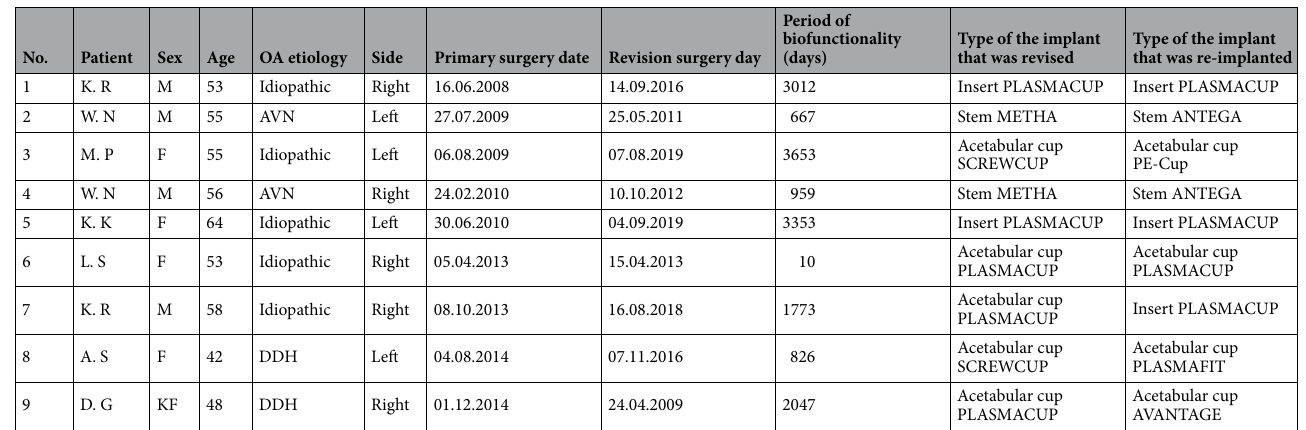
Table 2. Revision surgery both for acetabular and femoral failure. Data containing patients: gender, age, OA etiology, date of revision, type of the implant that was revised. OA osteoarthritis.